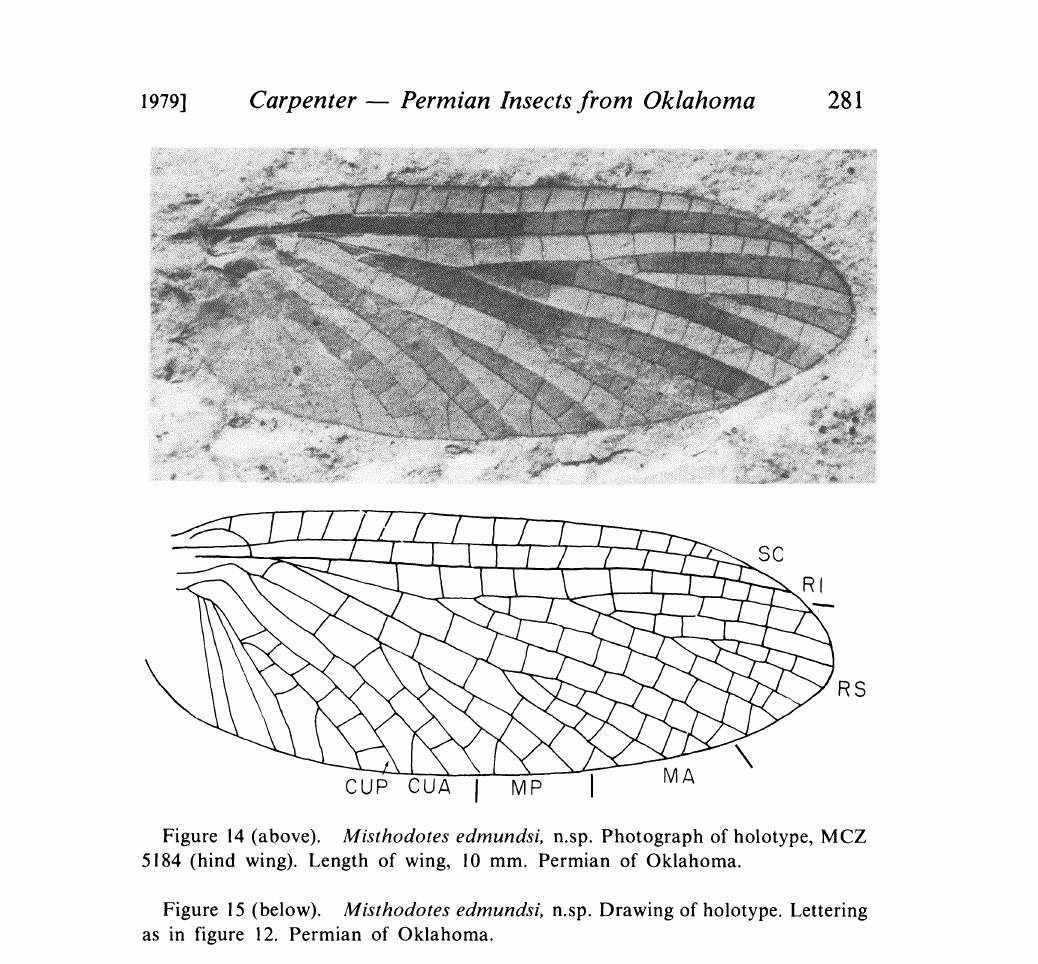
Figure 14 (above). Misthodotes edmundsi, n.sp. Photograph of holotype, MCZ 5184 (hind wing). Length of wing, 10 mm. Permian of Oklahoma. Figure 15 (below). Misthodotes edmundsL n.sp. Drawing of holotype. Lettering as in figure 12. Permian of